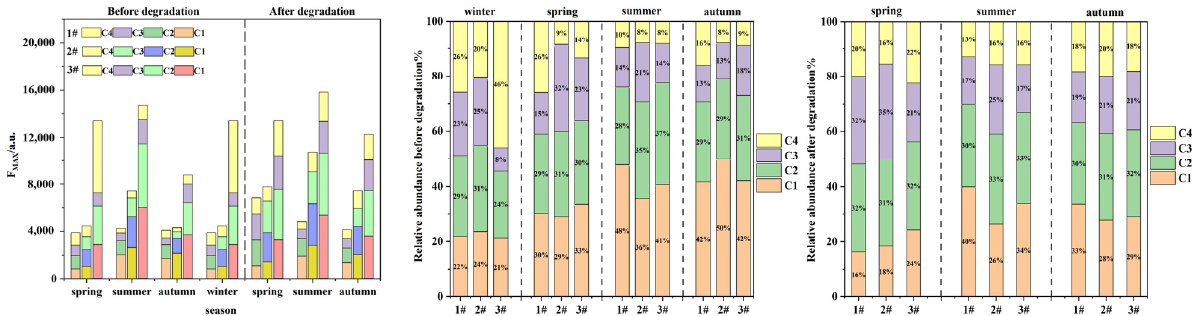
Figure 6. EEMs, maximum excitation/emission wavelength, and proportion of components before and after degradation in the Shili River ( left : before degradation; right : after degradation) .